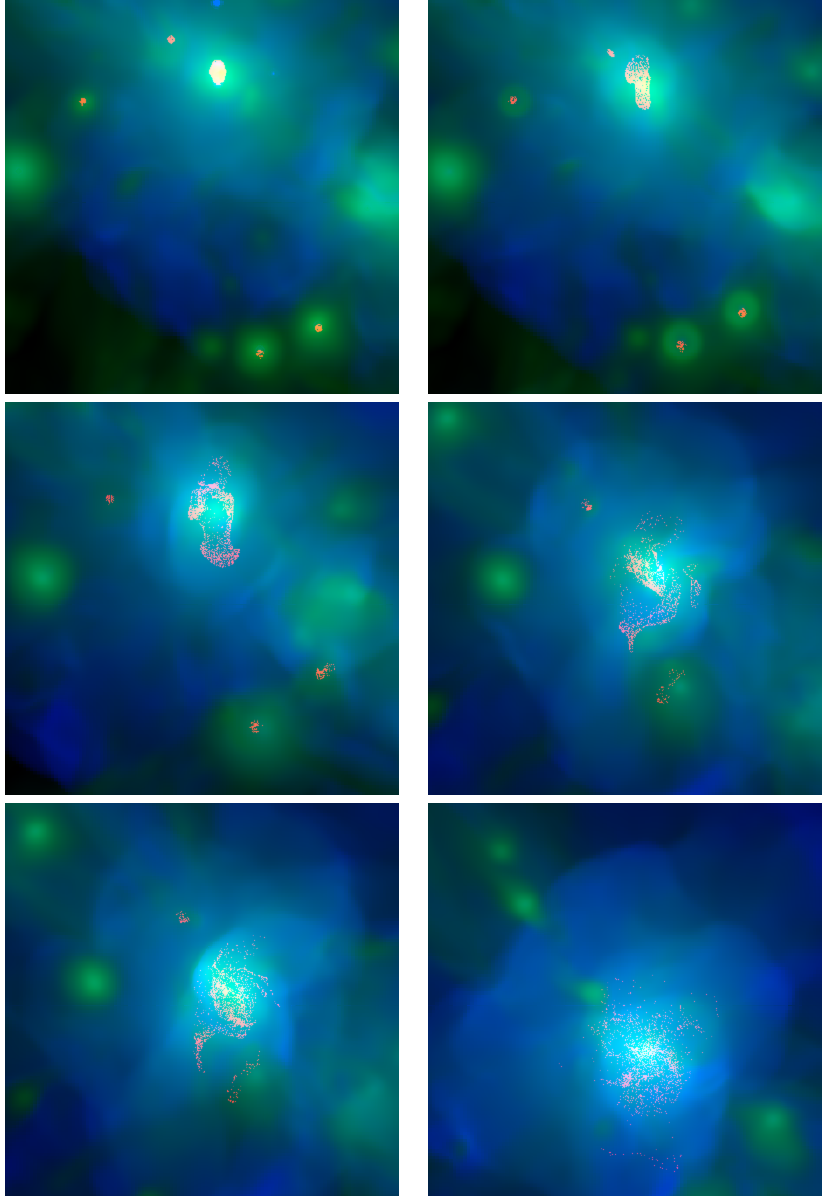
Figure 2. Red-green-blue composite images showing the evolution of our simulated cluster of galaxies, and of the location of electron tracers injected by our simulated (5) radio galaxies. Each image is 5 × 5 Mpc 2 across. They show the mass-weighted gas temperature projected along the full line of sight (blue), the projected gas density (green) and the location of the electron tracer, regardless of energy (red). From the top left to the lower right panel, the redshifts are z = 0.493, 0.452, 0.382, 0.201, 0.102, and